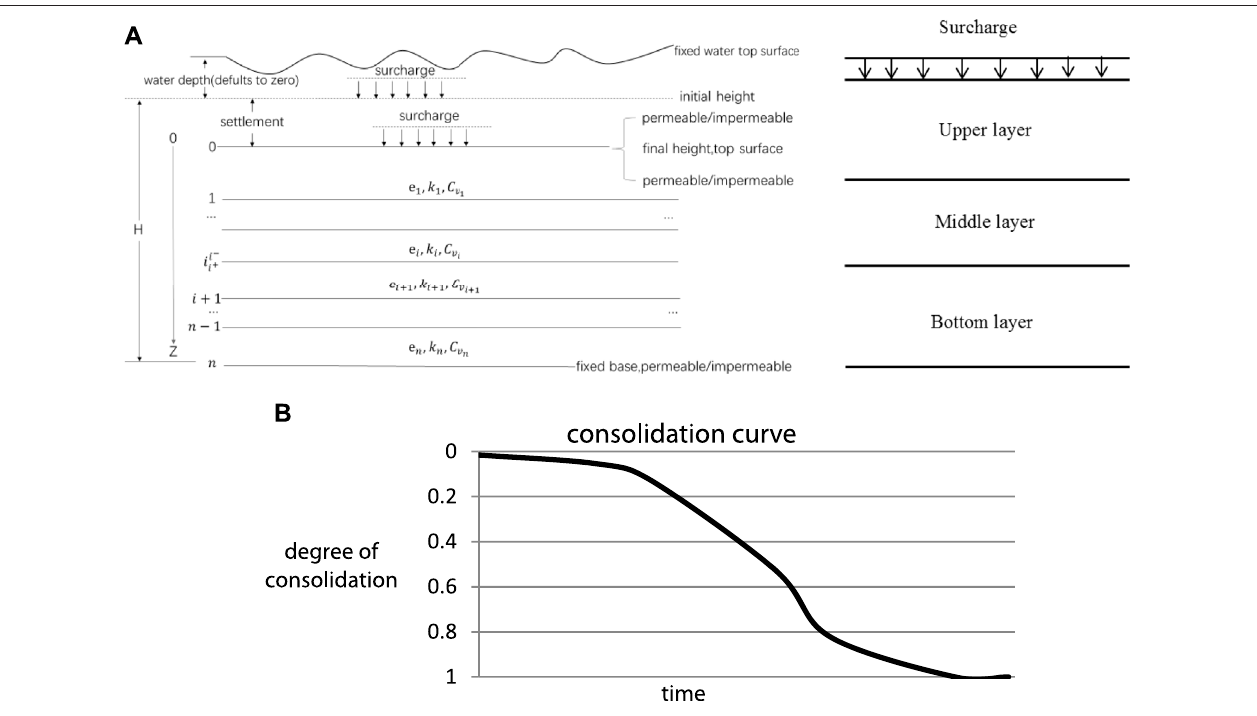
FIGURE 1 | (A) Consolidation model sketch map (left) , simpli fi ed sketch map of three layers with different properties (right) . (B) Consolidation curve.